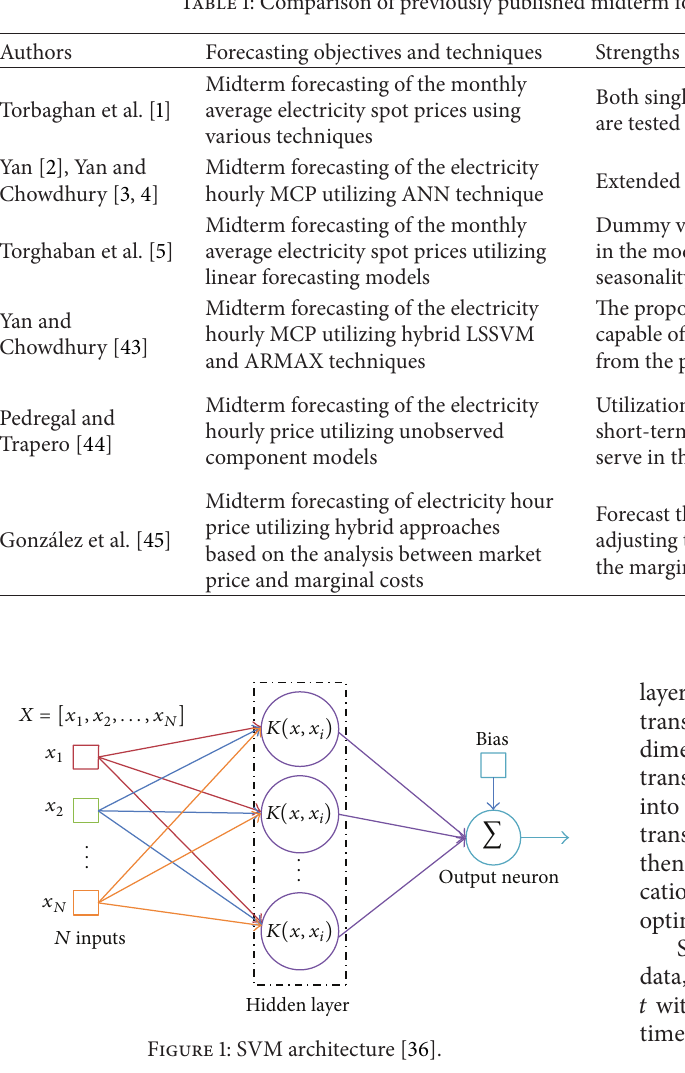
Table 1: Comparison of previously published midterm forecasting techniques of electricity prices.